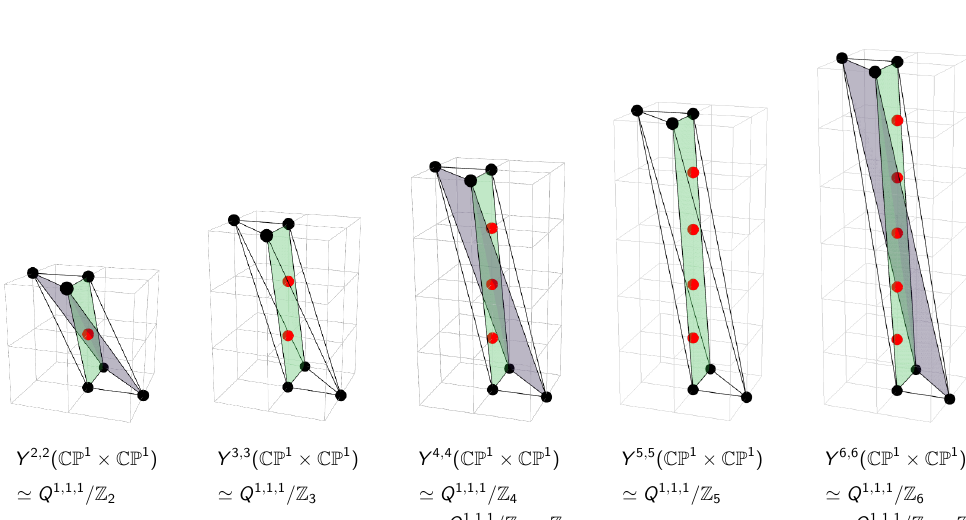
Figure 2 . Y p,k ( CP 1 × CP 1 ) with p = k is equivalent to the abelian orbifolds of the form Q 1 , 1 , 1 / Z p . If additionally p = k is even, Y p,k ( CP 1 × CP 1 ) is also equivalent to another abelian orbifold of the form Q 1 , 1 , 1 / Z 2 × Z p . The corresponding 2 d (0 , 2) theories can be obtained from orbifold reduction [35] of the 4 d N = 1 theory corresponding to F 0 or an abelian orbifold of F 0 . The planes shown in gray correspond to the toric diagram for F 0 and the planes shown in green correspond to the toric diagrams for abelian orbifolds of the form C / Z m , where C is the conifold.